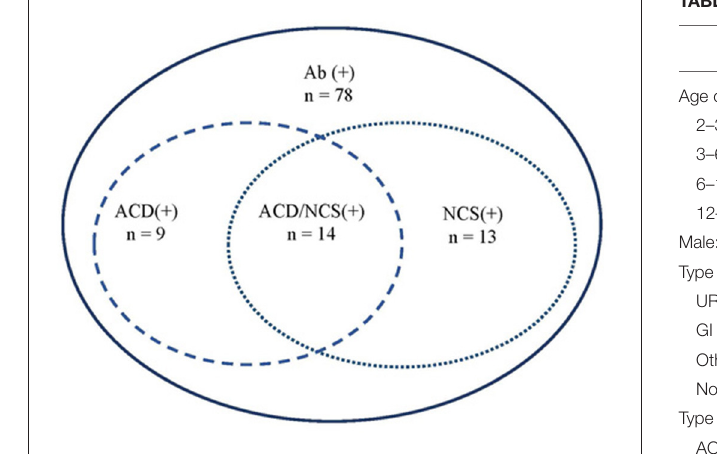
from 1:500 to 1:12,800. Serum anti-GT1a IgG antibody and anti-